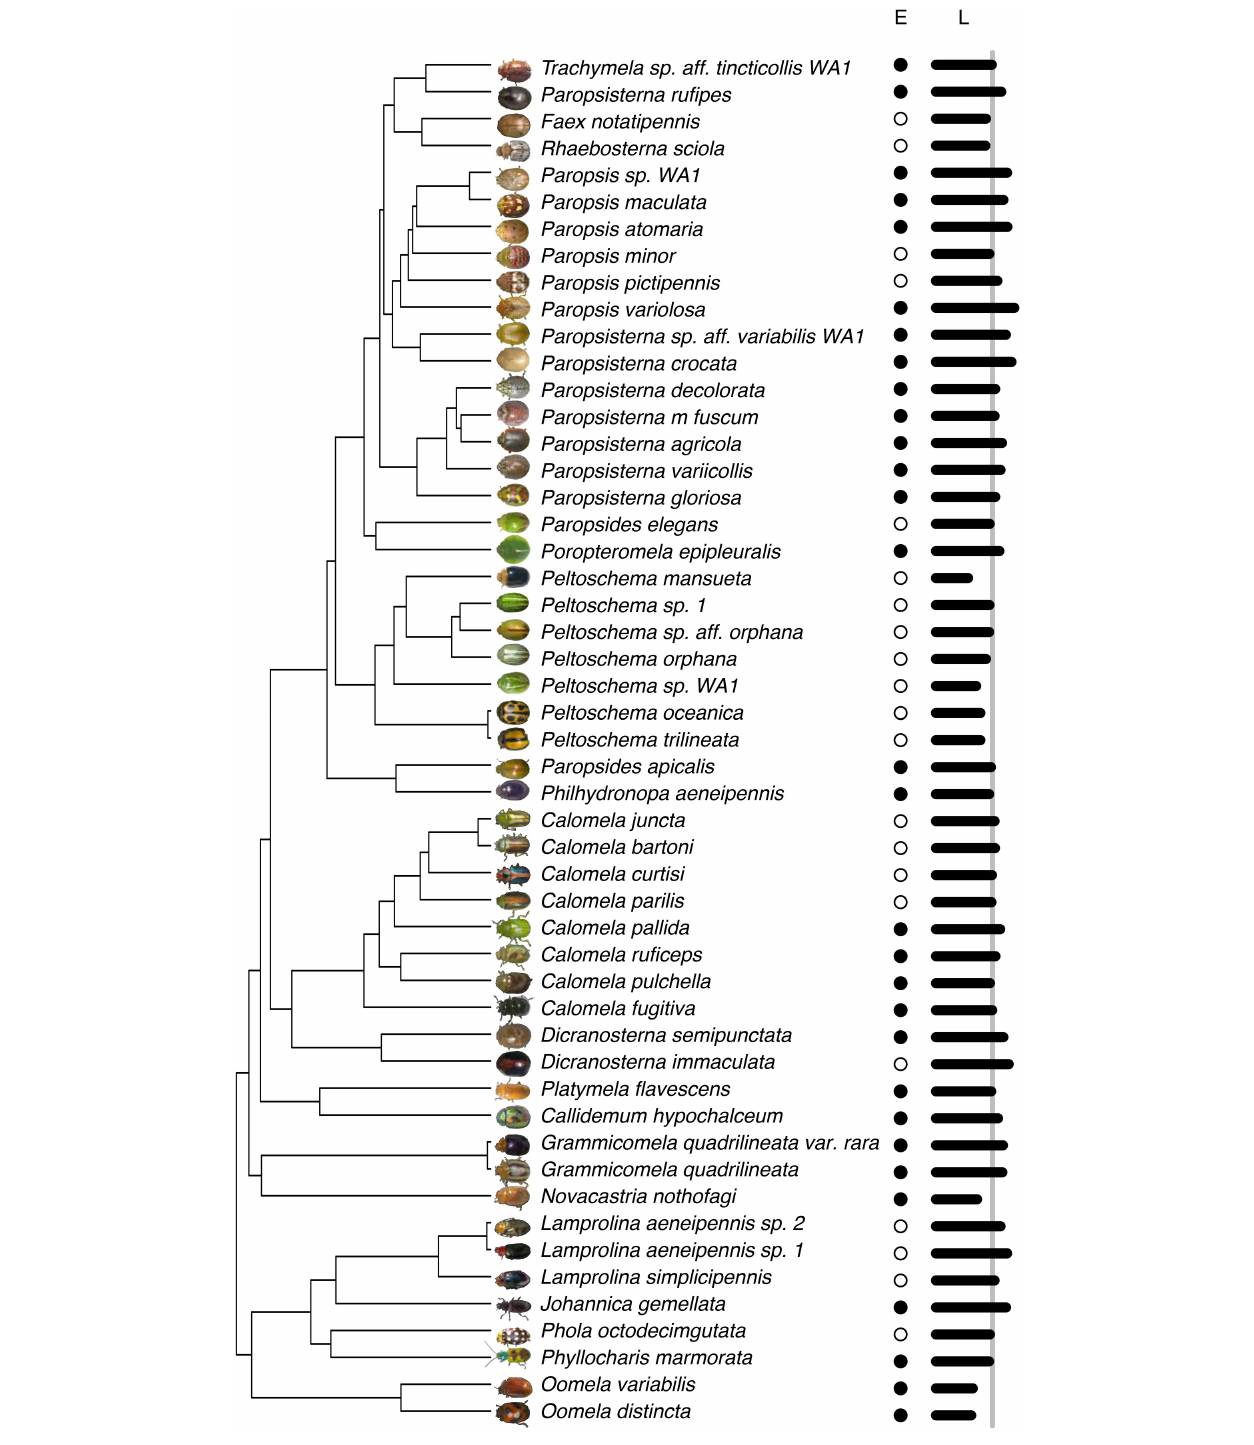
Frontiers in Ecology and Evolution |